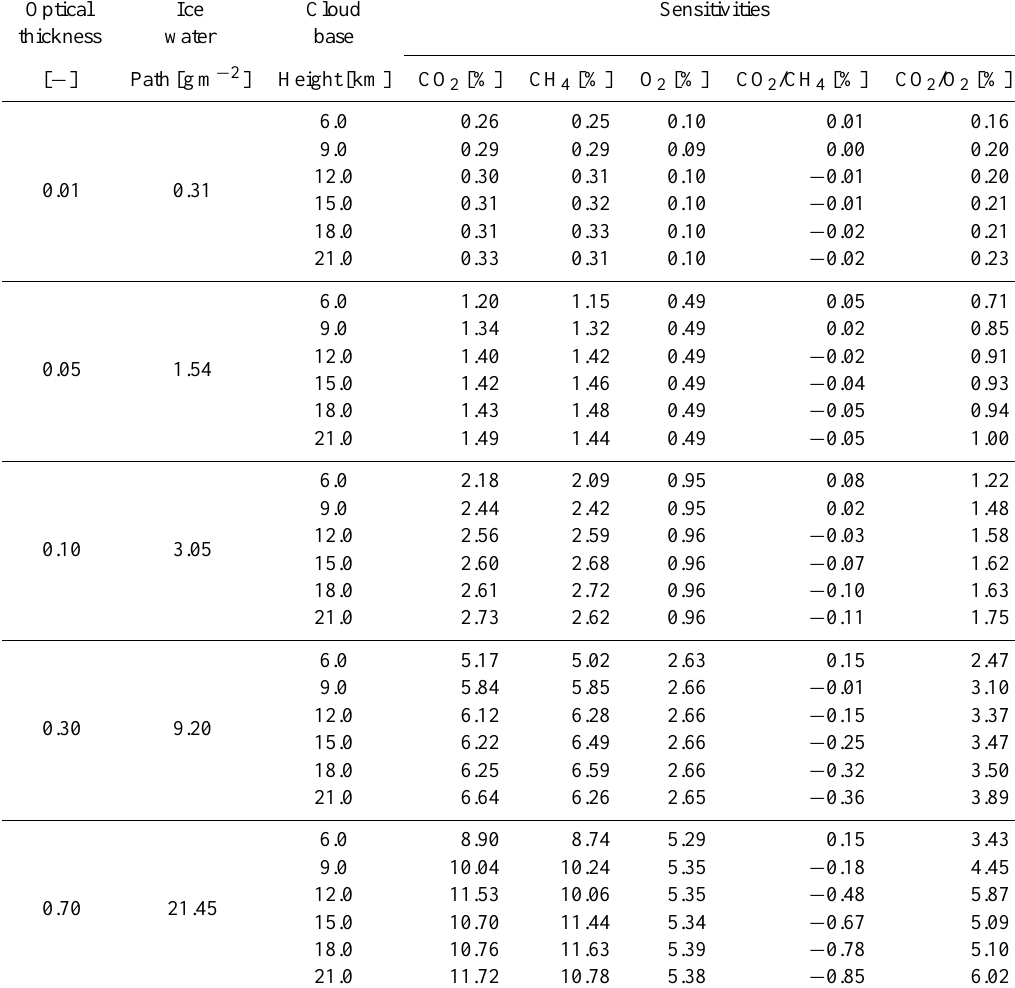
Table 6. Sensitivity to cirrus clouds for an aircraft altitude of 1.25km, a solar zenith angle of 40 ◦ and an albedo of 0.18 assuming a cirrus geometrical thickness of 500m.